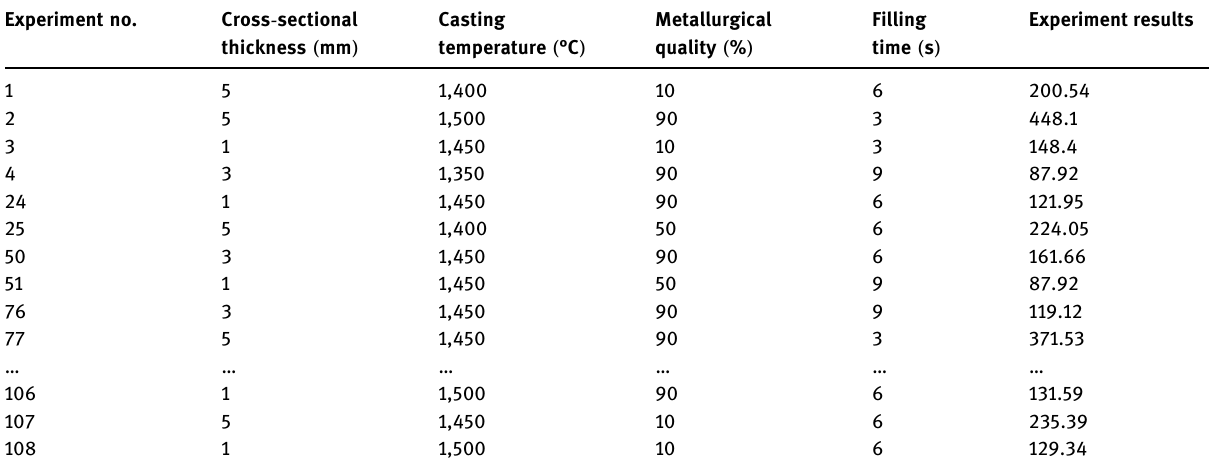
Table 3: Variation of fl ow distances of the liquid metal depending on the experimental parameters Experiment